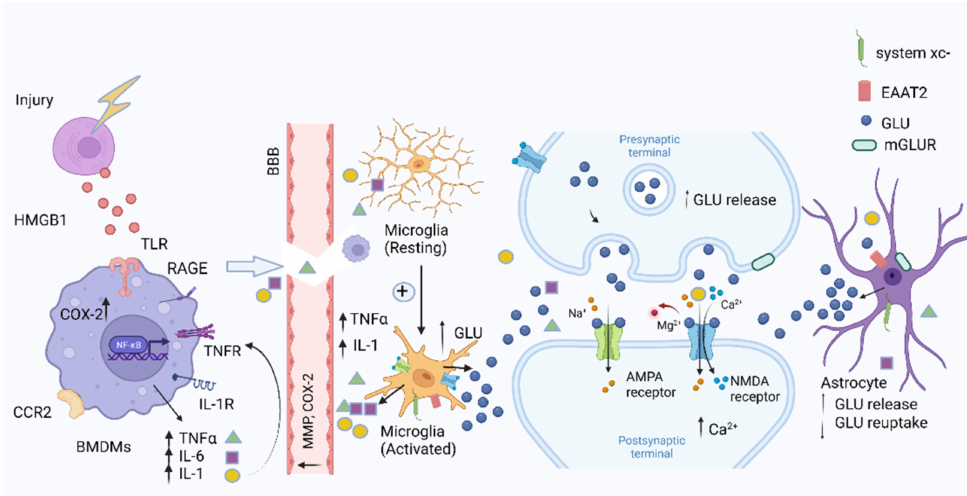
Figure 1. Systemic immune responses to trauma. Injured cells release DAMPs, including HMGB1, in response to surgical trauma after being combined with the TLR and RAGE, which can activate nuclear factor-kappa B (NF- κ B) signaling pathways in BMDMs, promoting the release of pro-inflammatory cytokines, including IL-6 and TNF α , IL-1. The increased expression of COX-2 and MMPs disrupts the integrity of the blood–brain barrier. Pro-inflammatory cytokines activate microglia to further amplify the release of pro-inflammatory cytokines in the brain. Glia activated by the pro-inflammatory cytokines can further stimulate the release of glutamate. The postsynaptic intracellular Ca 2+ concen- tration increases by the overactivation of NMDARs. The ability of astrocytes to clear glutamate is decreased. Figure created with Biorender.com (accessed on 2 March